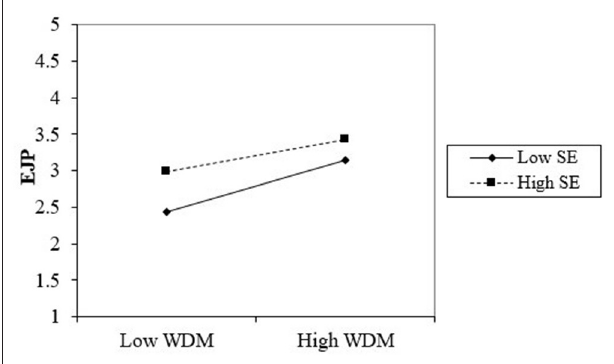
FIGURE 4 | Interaction graph SE*WDM and EJP. WDM, workforce diversity management; SE, structural empowerment; EJP, employee job